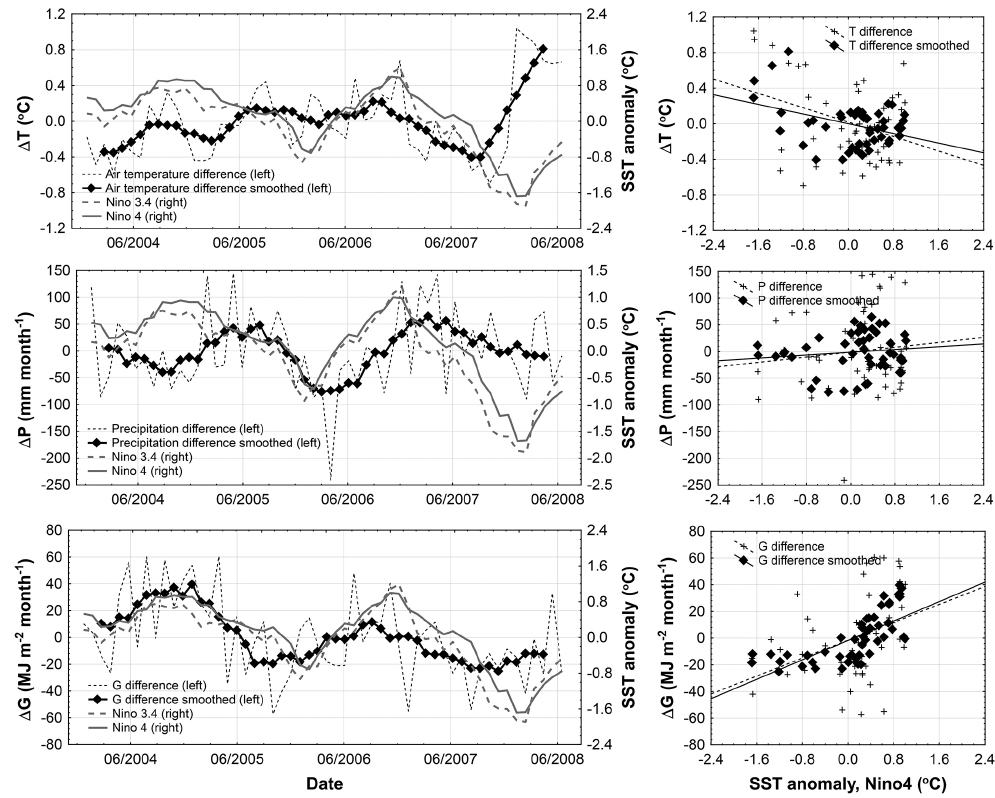
Figure 4. Comparisons of interannual patterns of SST anomalies in Nino4 and Nino3.4 zones of the equatorial Pacific with variability in both deviations and 7-month ( ± 3 months) moving average deviations of monthly air temperature ( T ), precipitation ( P ) and global radiation ( G ) values from mean monthly values of T , P and G averaged over the entire measuring period from 2004 to 2008.